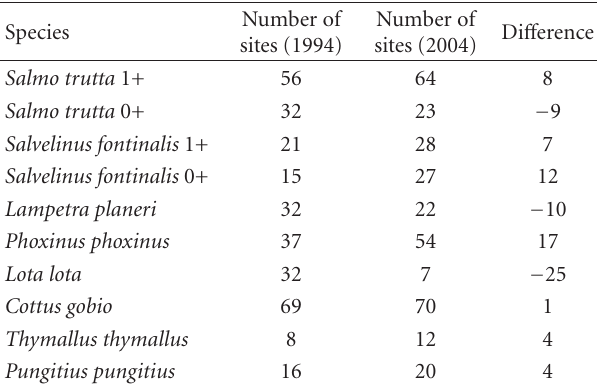
Table 2: The number of sites occupied by the native species and the alien brook trout ( Salvelinus fontinalis ). Total number of sites was 78 in both